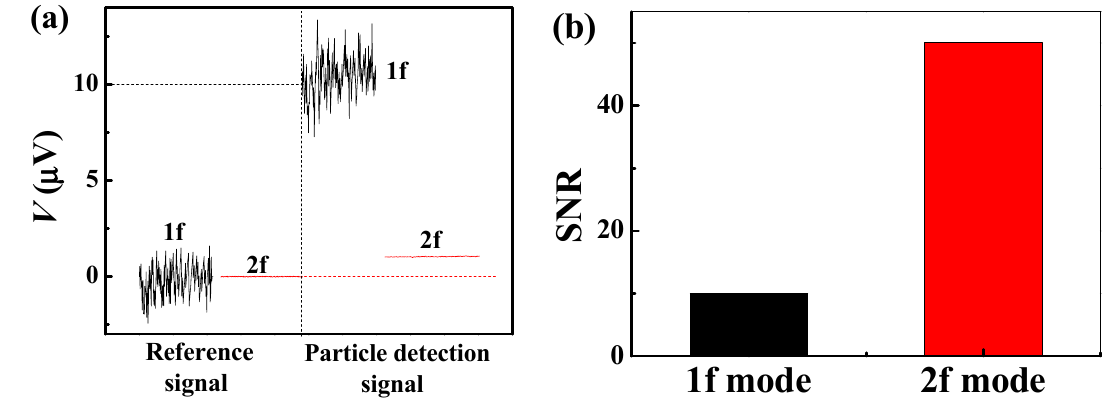
Figure 3. ( a ) Comparison of particle detection signal in the 1f and 2f detection modes and ( b ) comparison of signal-to-noise ratio (SNR) in the 1f and 2f detection modes.